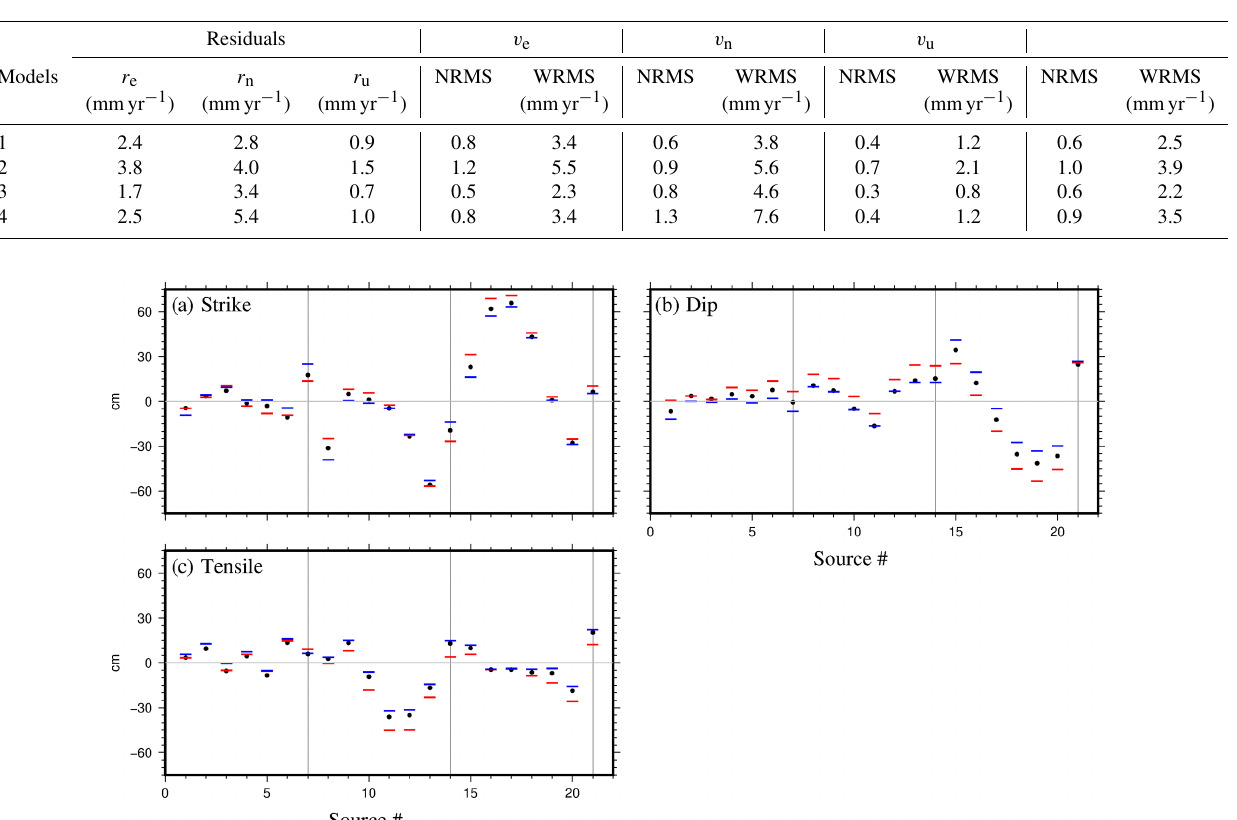
Figure 10. Interval of confidence (2 σ ) for the dislocation parameters of the 21 sources: (a) strike slip, (b) dip-slip, and (c) tensile. The black dots represent the optimal value of the parameter; red and blue are associated with the two extreme scenarios ( v + and v − , respectively) obtained using the backward uncertainty propagation previously described. The black lines on the graphs separate the sources contained in the three lines that composed the model. The gray line indicates zero deformation of the